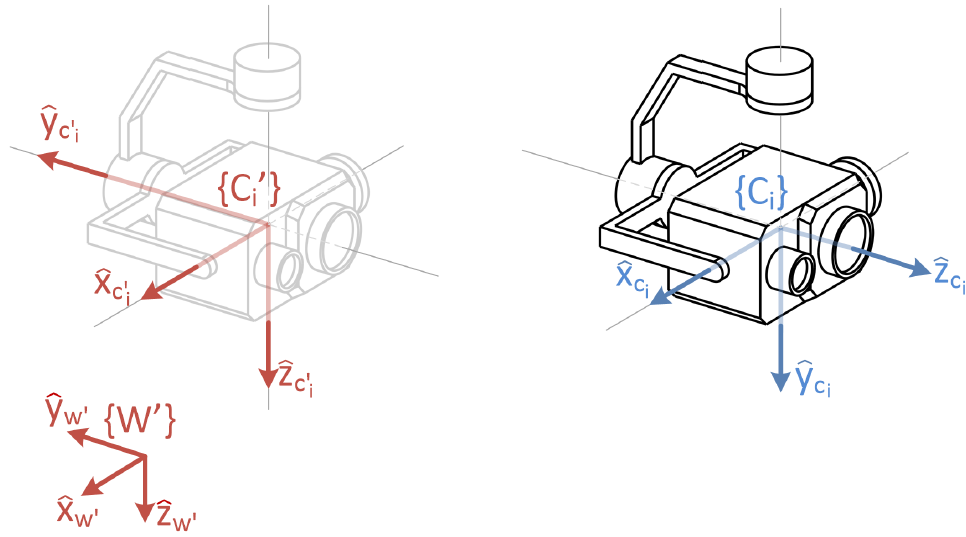
Figure 2. Proposed gimbal structure and associated reference